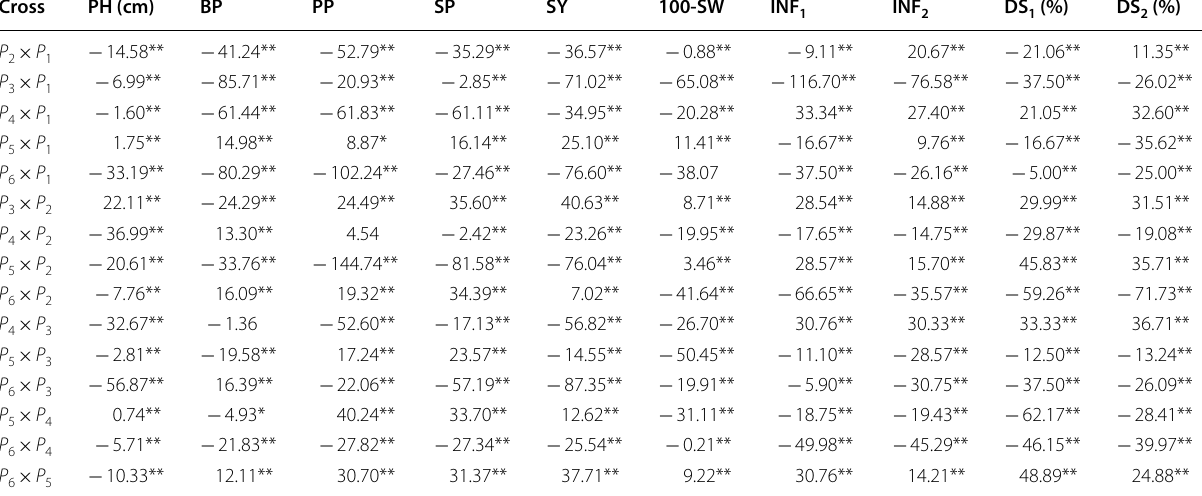
for studied traits 2